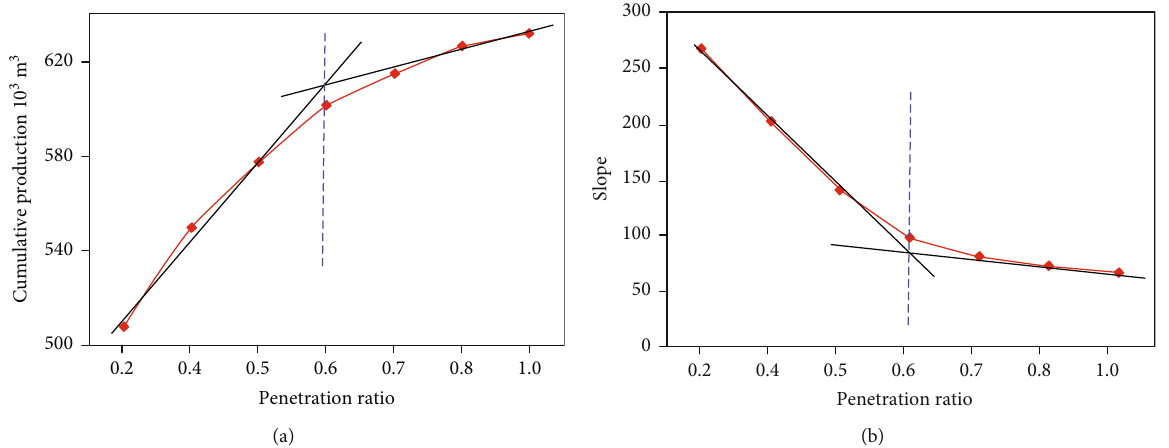
Figure 7: Cumulative oil production curves for di ff erent hydraulic fracture penetration ratios. (a) Cumulative oil production versus penetration ratio, and (b) slope of the cumulative oil production curve versus penetration